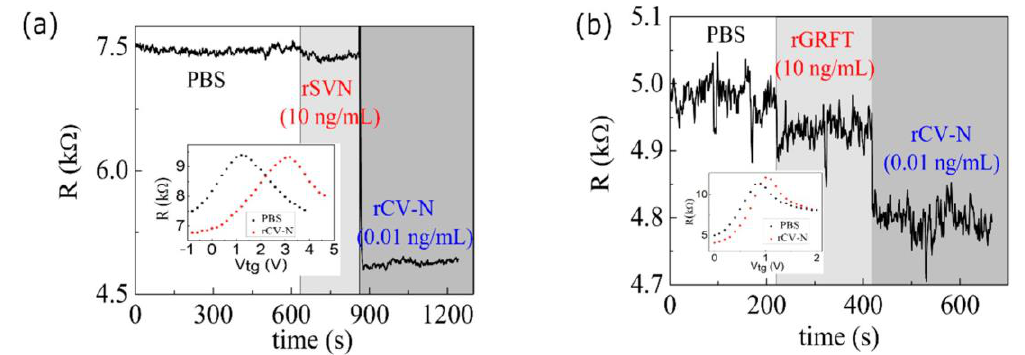
Figure 5. Resistance versus time of a graphene ISFET in contact with solutions of ( a ) PBS, rSVN and rCV-N and ( b ) PBS, rGRFT and rCV-N, in this order. The insets show the resistance versus gate voltage plots for the devices covered with PBS (black dots), and, subsequently, with rCV-N (red dots).